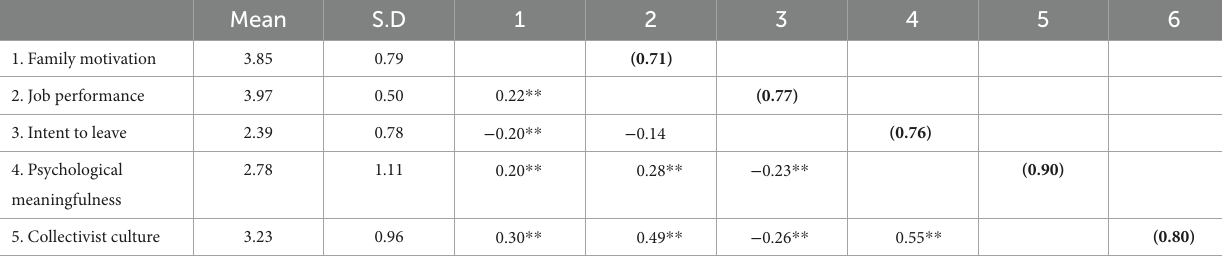
TABLE 1 Correlations and descriptive